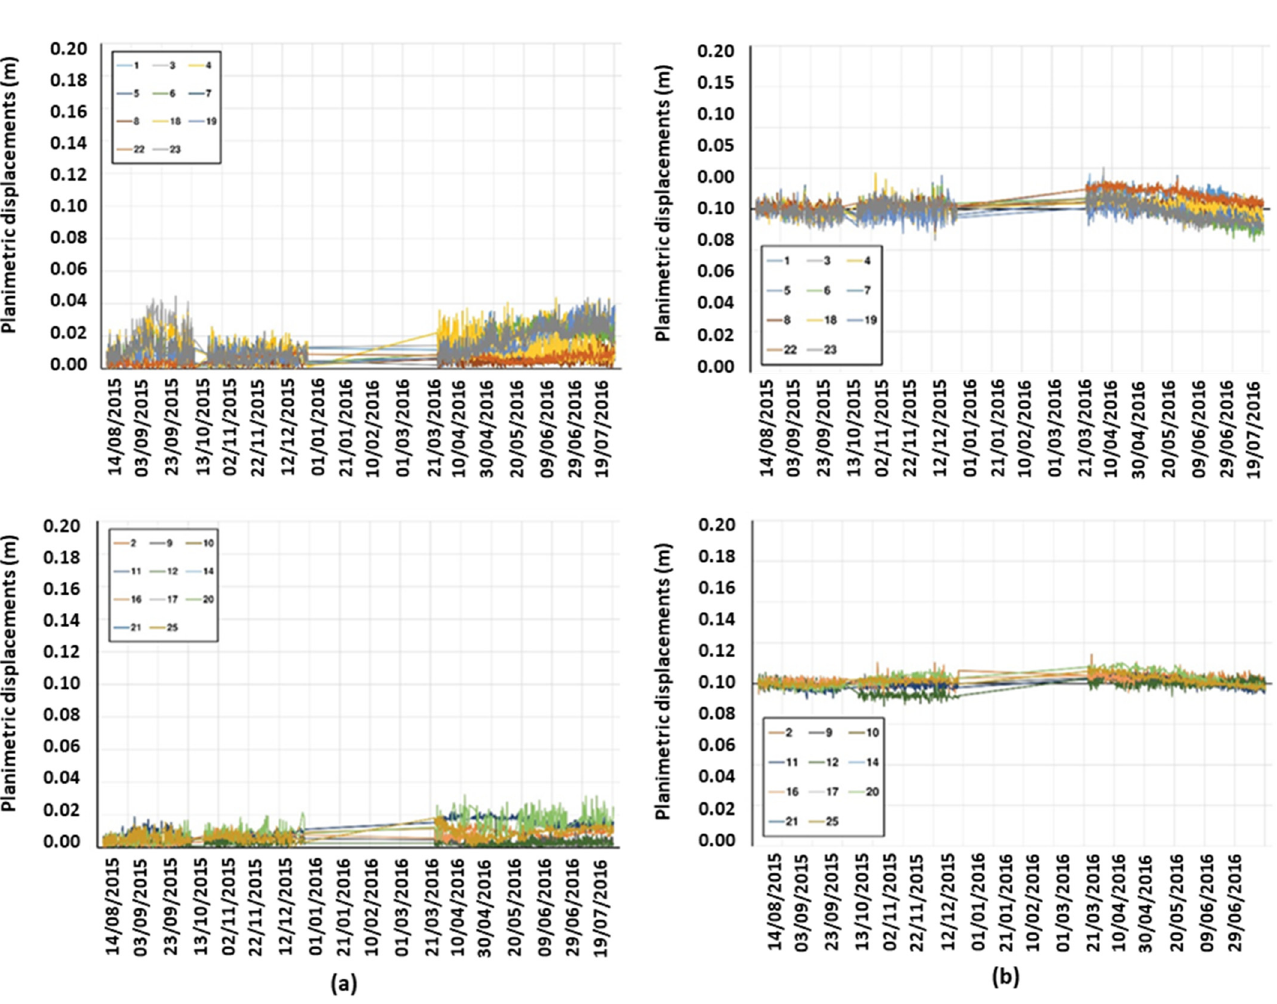
Figure 14. Post-failure RTS displacement monitoring data for the landslide area (upper graphs) and the upslope area (lower graphs): ( a ) horizontal component and ( b ) vertical component.